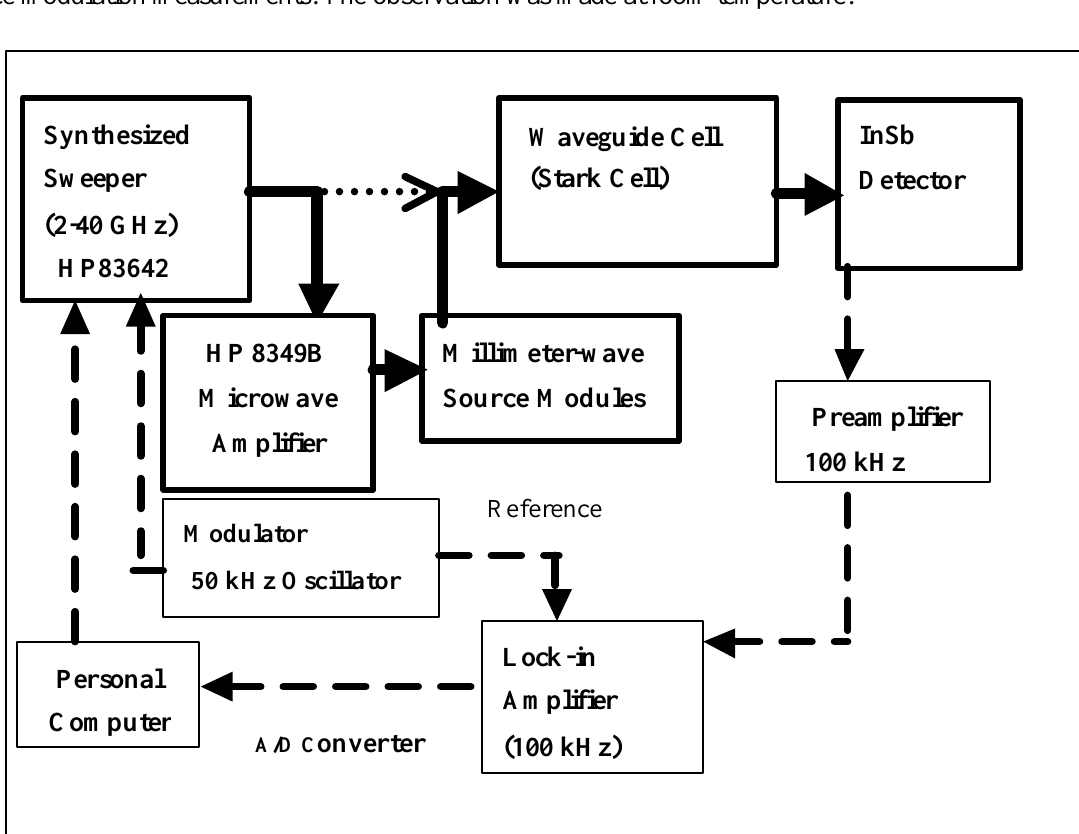
Figure 2. Block diagram of